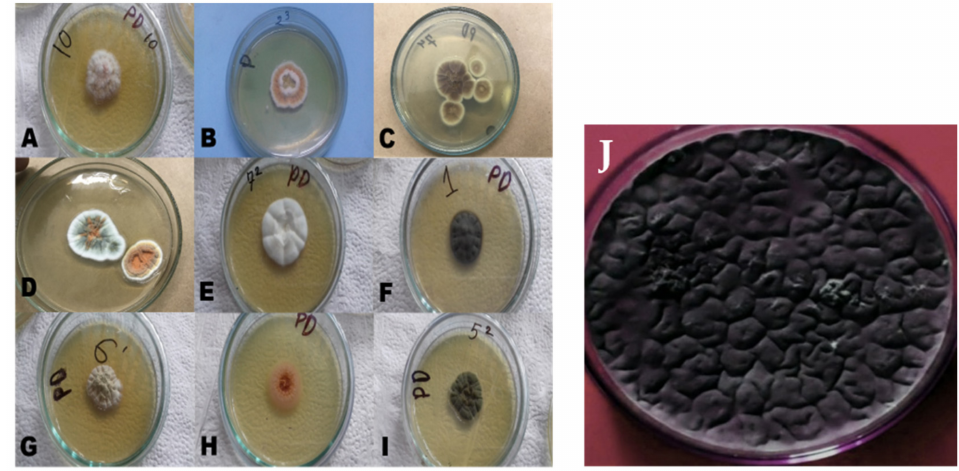
Figure 3. Different unidentified soil-borne fungi ( A – I ) and a cultural characterization of Aspergillus niger ( J